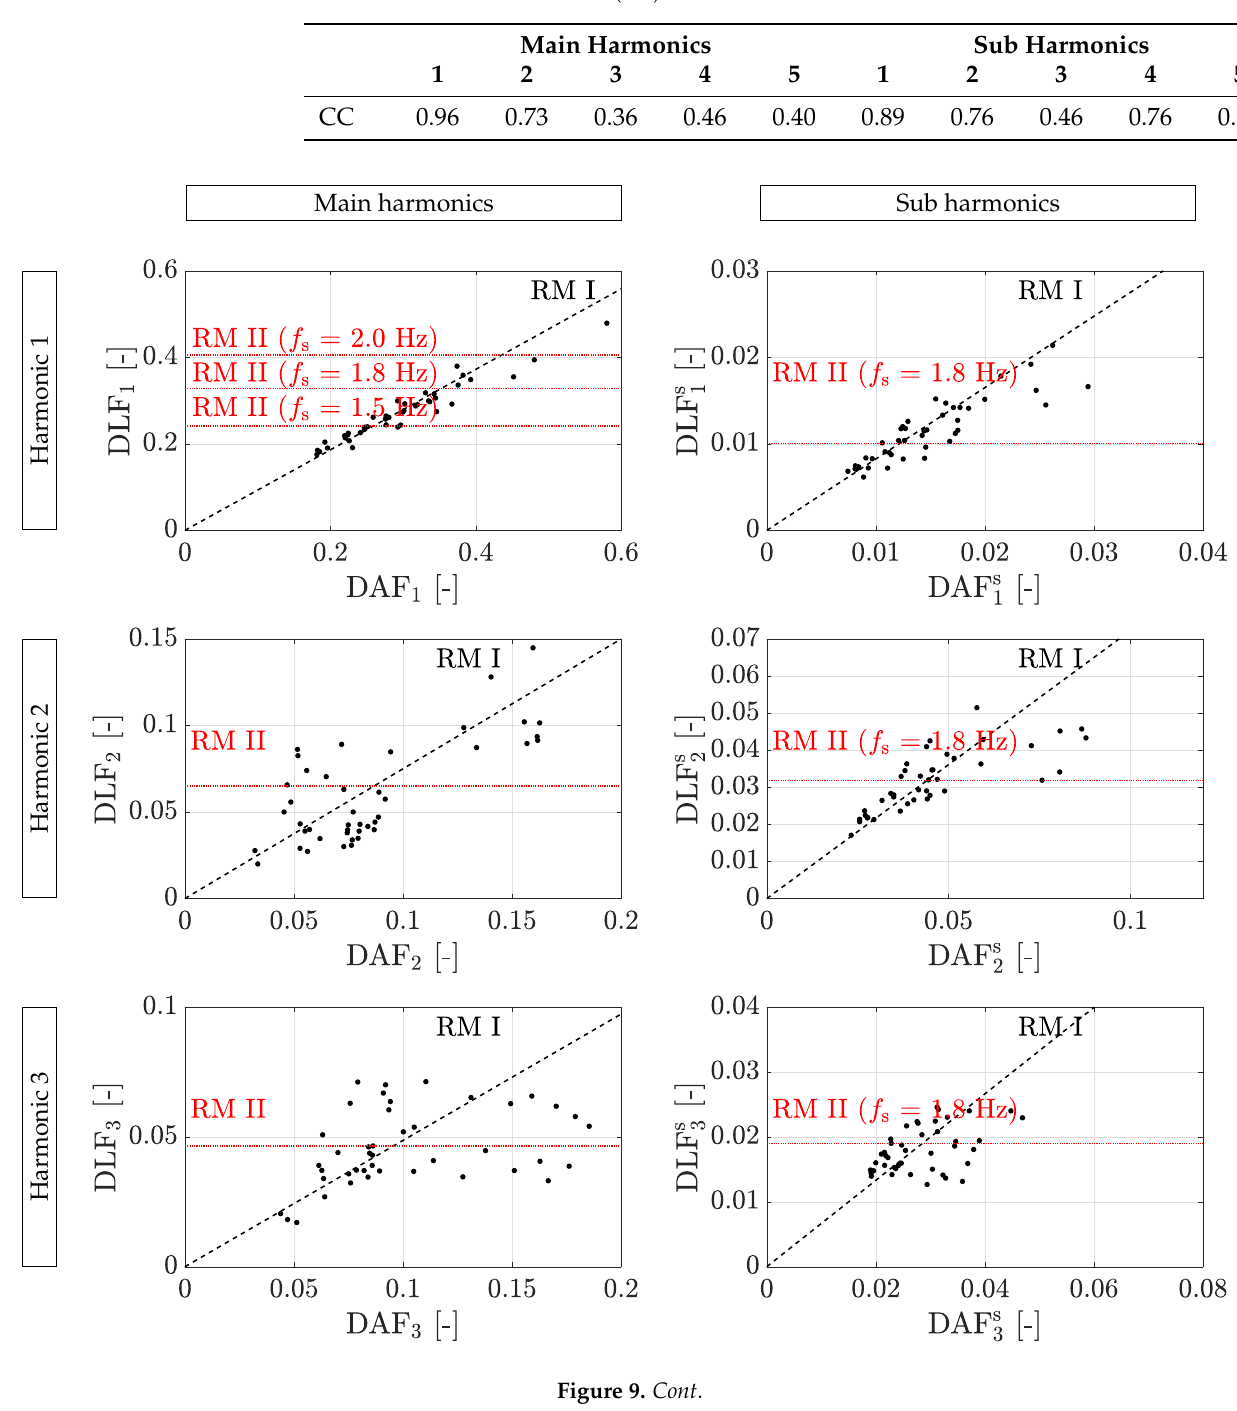
Table 2. Correlation coefficient (CC) between the DAF and DLF for the different harmonics.